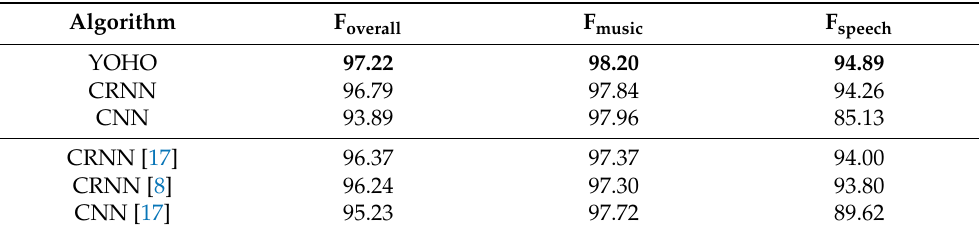
Table 5. Results on our in-house test set for music-speech detection. The F-measures for overall, music, and speech are presented as percentages. The values in bold indicate the largest number in each column.